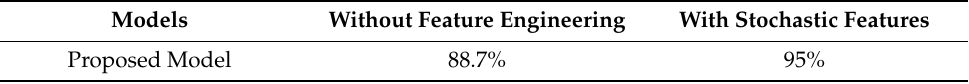
Table 5. Performance improvement of the proposed model against stochastic feature engineering.